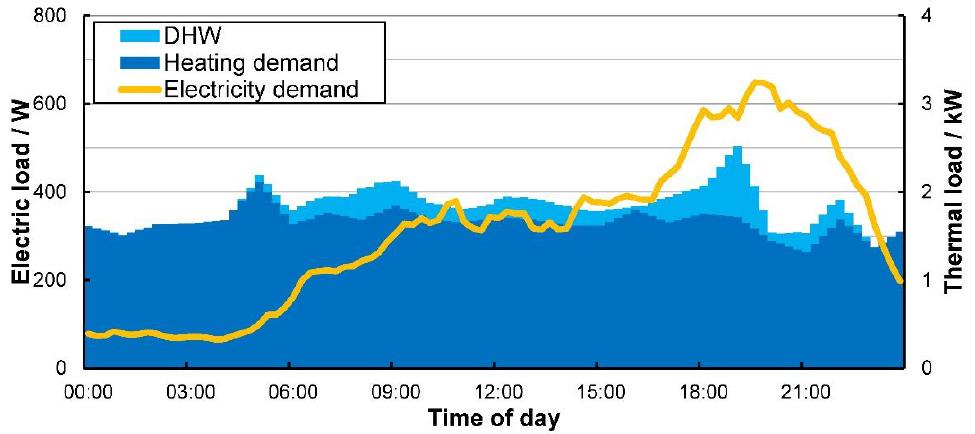
Figure 1. Daily load profiles for a single-family house (SFH) showing demands for space heating, domestic hot water (DHW, cumulative to space heating) and electricity demand.